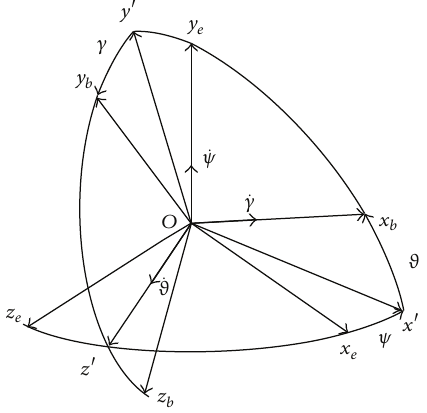
Figure 1: Rotational relationship of 𝑂𝑥 𝑒 𝑦 𝑒 𝑧 𝑒 and 𝑂𝑥 𝑏 𝑦 𝑏 𝑧 𝑏 .